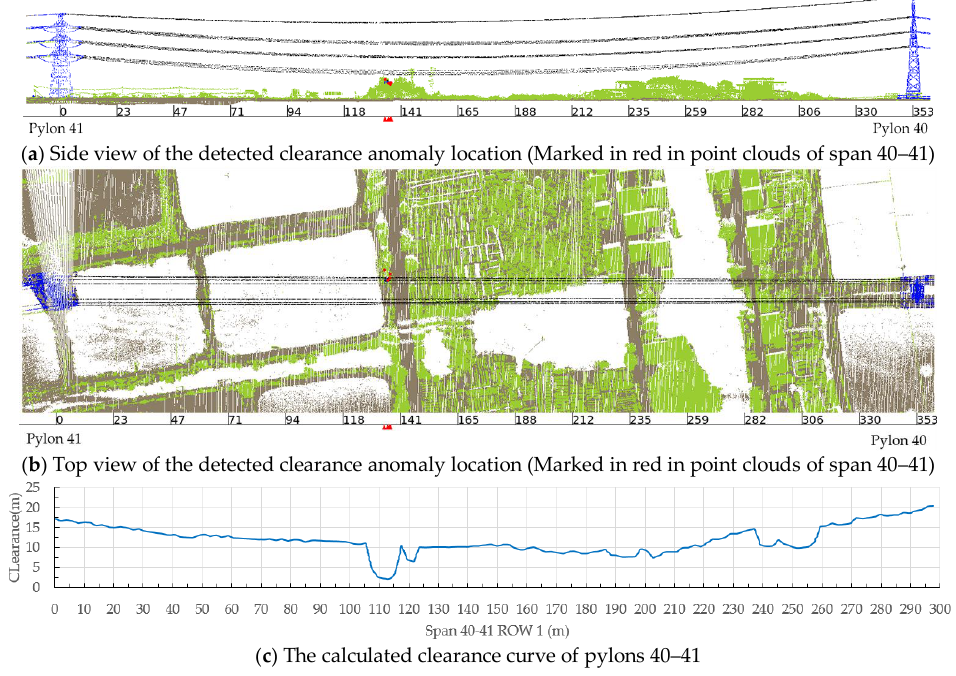
Figure 13. The detected clearance anomaly between pylons 40and 41 in ROW 1.